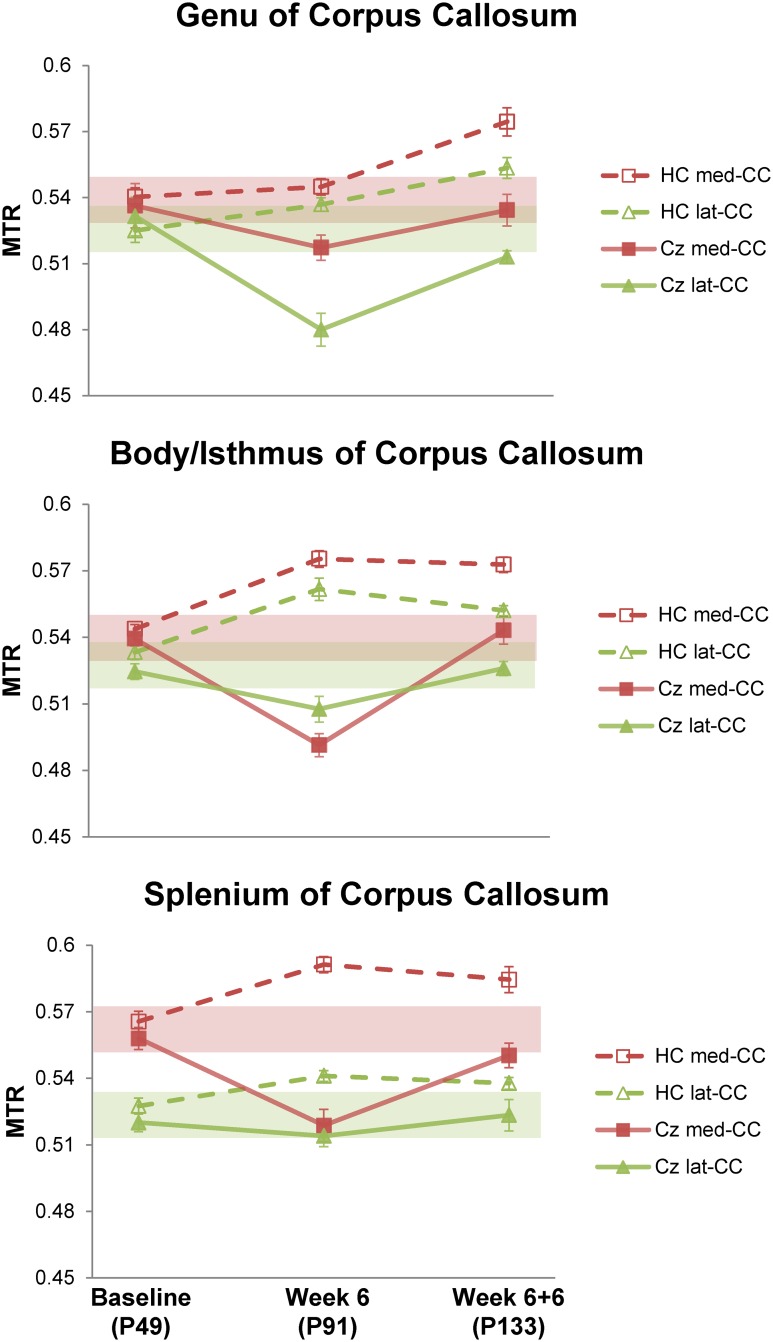
Longitudinal ROI-average MTR Compared to Healthy Age-Matched Controls.ROI-average MTR scatter plots for the medial- and lateral-CC ROIs illustrated in Fig 2(a)–2(c). Values represent population average within an ROI. Dashed lines/hollow markers represent data from healthy age-matched controls (n = 10, 4, 5, for Baseline (age postnatal (P) 49), Week 6 (P91), Week 6+6 (P133), respectively); data from cuprizone treated animals are shown with solid lines/filled markers (n = 14, 14, 5, for Baseline, Week 6, Week 6+6, respectively). Error bars represent mean standard error for each group. The shaded bands illustrate the 95% confidence interval for baseline values (±0.01).